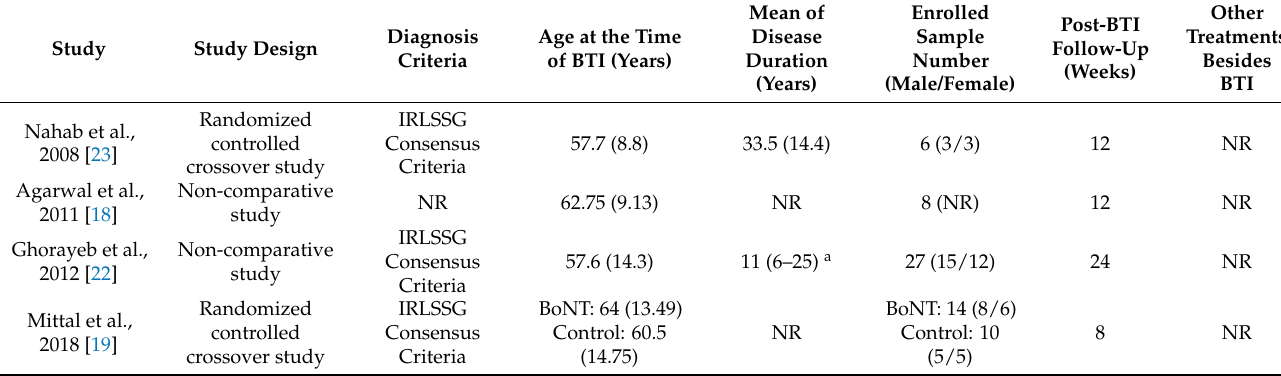
Table 1. Characteristics of all included